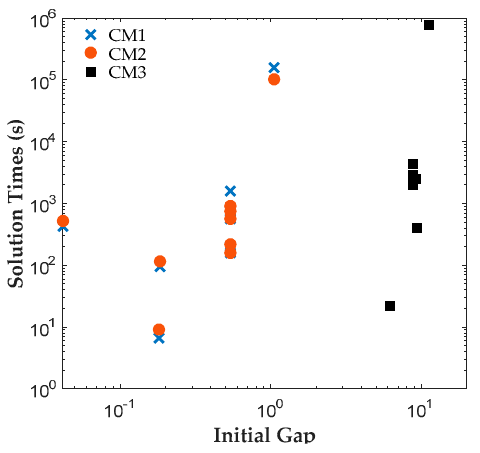
Figure 7. Change in solution times with changes in initial gaps of CM1, CM2 and CM3. Initial gaps of CM1 and CM2 are consistently smaller than CM3.